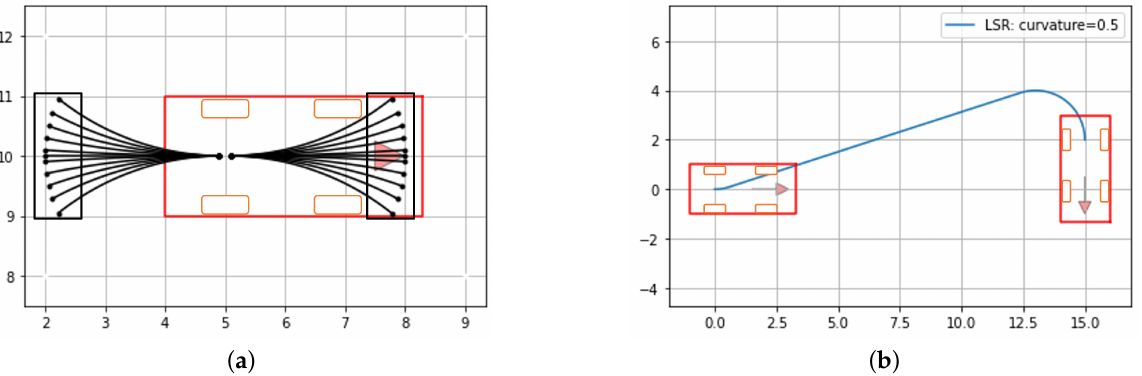
Figure 1. Hybrid state A-star method. ( a ) Successor selection in continuous domain. ( b ) Reeds-Shepp